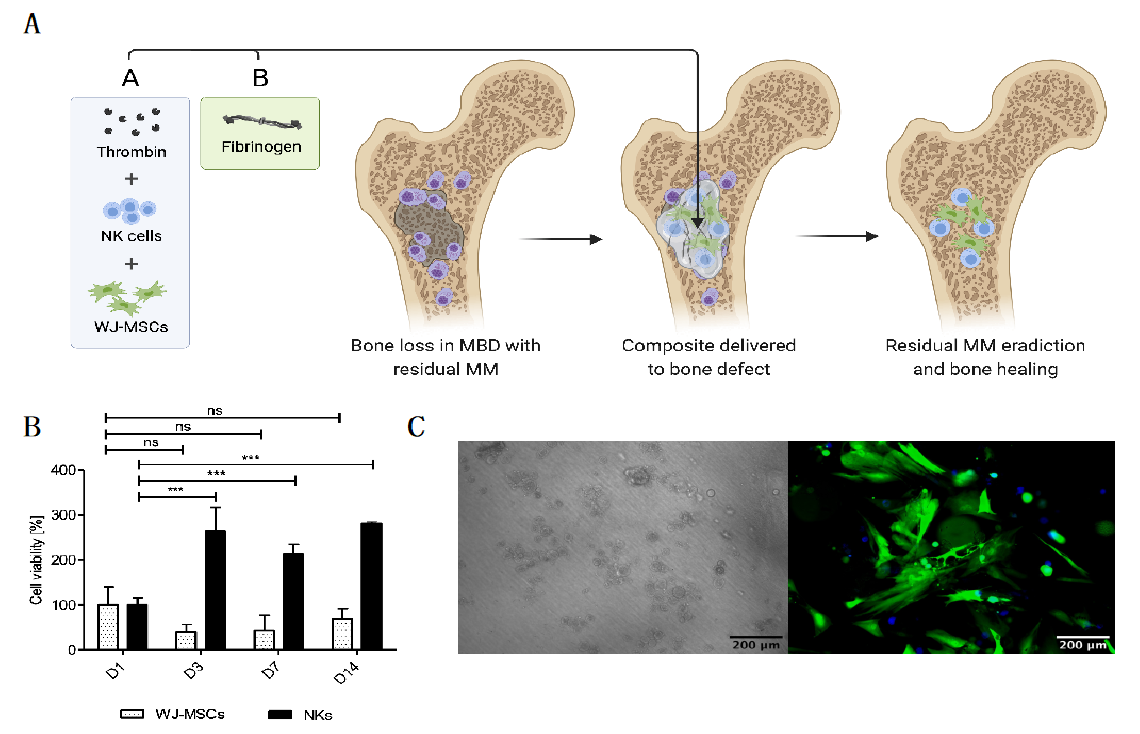
Figure 1. Novel “off-the-shelf” local immunotherapy for myeloma bone disease treatment combining NKs and WJ-MSCs within the fibrin matrix (FINM). ( A ) Schematic drawing of novel local immunotherapy concept leading to myeloma lesions eradication and bone healing after delivery of FINM. ( B ) Viability of WJ-MSCs and NKs at different days (D1, D3, D7, D14) after embed (D0) in fibrin scaffold. ( C ) Fluorescence microscopic image of WJ-MSCs expressing green fluorescence protein (green) within fibrin matrix together with NKs expressing cyan fluorescence protein (blue), at D14 after seeding (scale bar = 200 μm). Data in ( B ) are presented as means ± SD from three technical replicates. ns—not significant; *** ‒ p < 0.001; one-way ANOVA, repeated measures test and Student’s t -test.